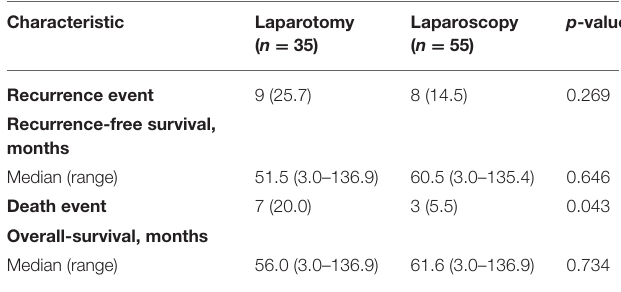
TABLE 4 | Survival comparison by patients group with laparoscopy and